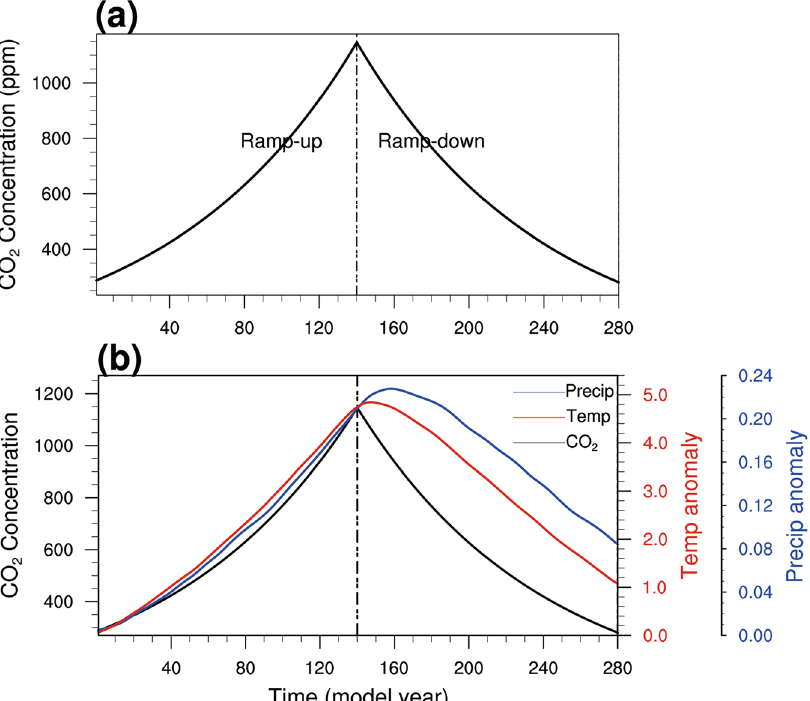
Fig. 1 The global mean surface temperature and precipitation changes in the idealized CO 2 ramp-up and ramp-down experiments. a The evolution of the atmospheric CO 2 concentration (unit: ppm) in CDR experiments. b The global mean surface temperature (GMST; unit: K) and precipitation (GMP; unit: mm day − 1 ) responses in CO 2 ramp-up and ramp-down experiments relative to the PI from the MME. Time series of the CO 2 concentration (black line; unit: ppm), annual GMST (red line), and GMP (blue line) anomalies. A 3-point (1/4,1/2,1/4) fi lter with 40 times is used to remove interannual variability. The vertical dashed line denotes Year 140 when CO 2